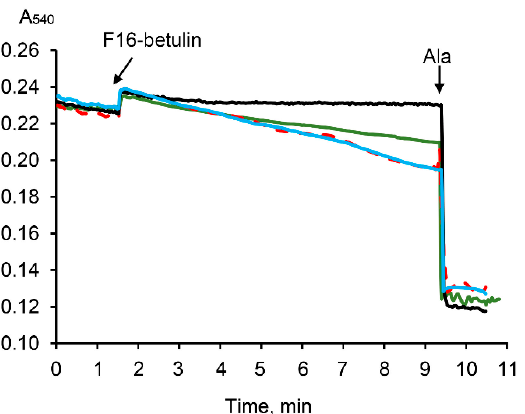
Figure 6. Effect of F16-betulin conjugate on the optical density of a suspension of liver mitochondria. Additions: 30 µ M of F16-betulin conjugate in the presence of glutamate plus malate ( green line ) and succinate plus rotenone ( blue line ). The effect of 1 µ M cyclosporin A (CsA) on changes in the optical density of succinate-fueled mitochondria induced by the conjugate is shown by the red dashed curve . Black line reflects the kinetics of changes in the optical density in the absence of oxidation substrates. Alamethicin (Ala, 5 µ g/mL) was used to show the maximum possible decrease in the optical density of the mitochondrial suspension at the end of the recordings. A similar pattern was observed in three independent experiments.